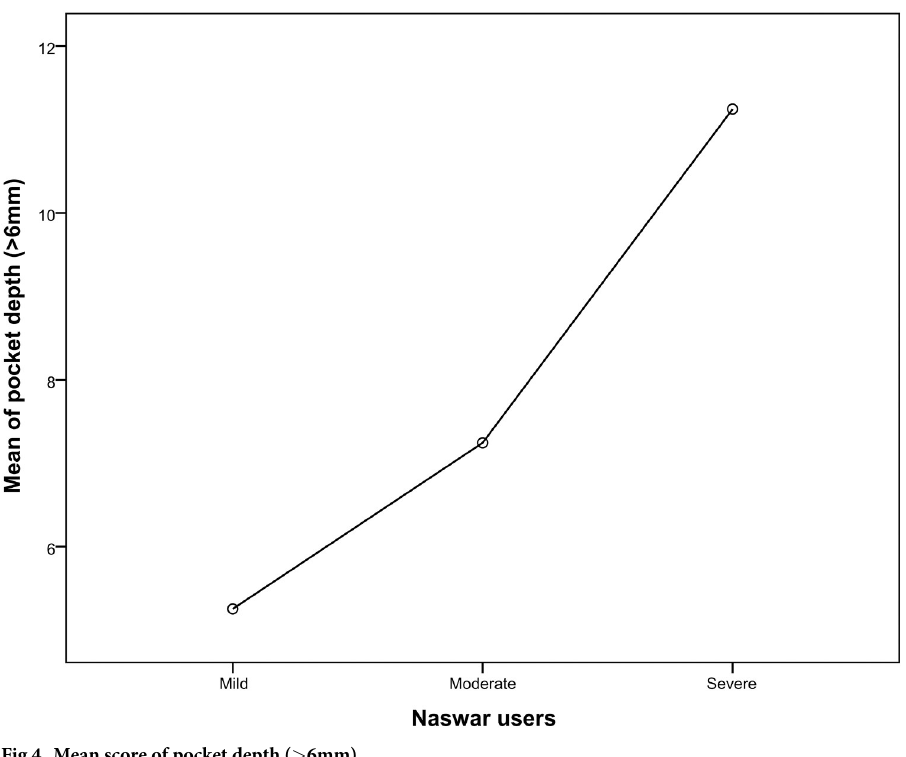
Fig 4. Mean score of pocket depth ( > 6mm).